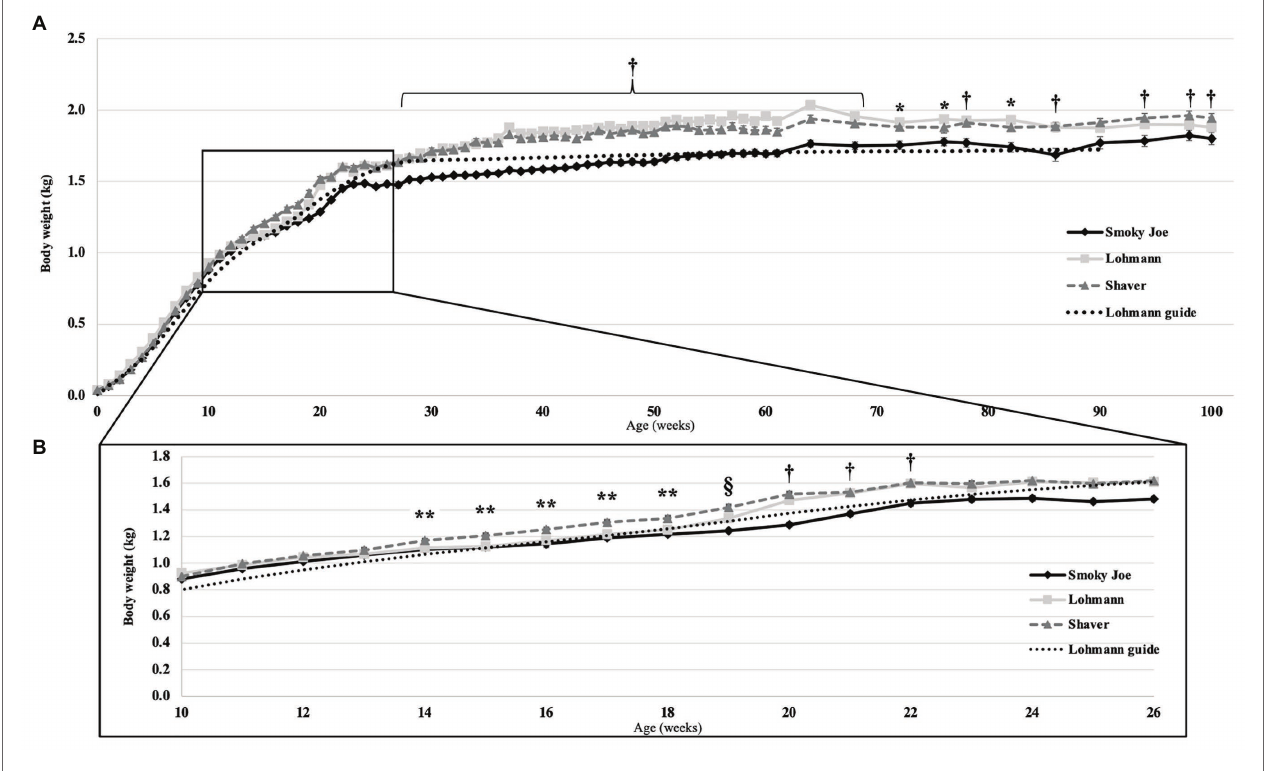
FIGURE 1 | (A) Body weight (BW) of the Lohmann, Shaver, and Smoky Joe hens, along with the Lohmann guidelines predicted production (Lohmann-Tierzucht, 2015) from 0 to 100 weeks of age (woa). p -values for the sources of variation: Age, p < 0.0001; Strain, p < 0.0001; Interaction, p < 0.0001. (B) BW emphasized from 10 to 26 woa in these same strains. *Lohmann > Smoky Joe, **Shaver > Lohmann and Smoky Joe, † Shaver and Lohmann > Smoky Joe, and § Shaver > Lohmann > Smoky Joe.